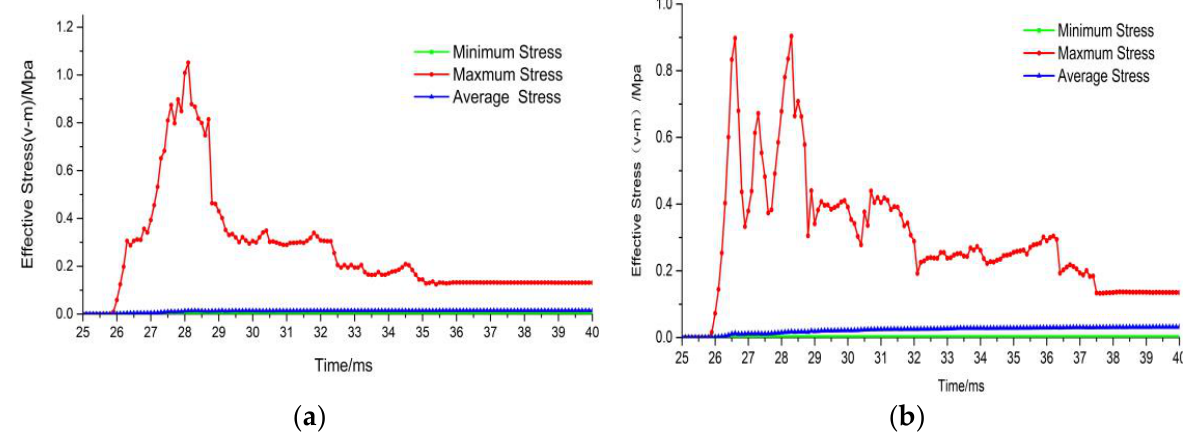
Figure 9. Equivalent stress curves of cutting blade: ( a ) upper cutting blade; ( b ) bottom cutting blade.